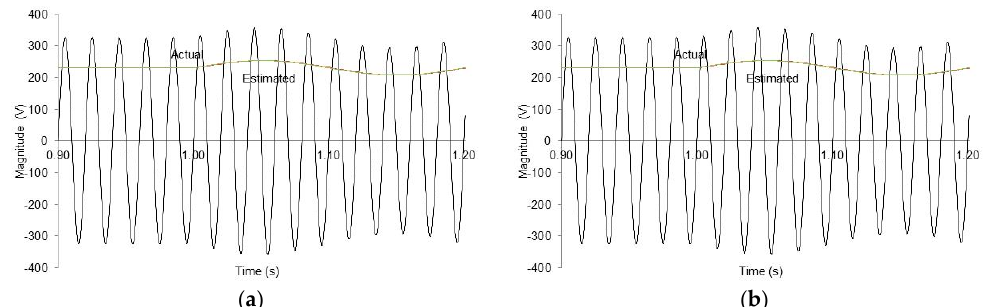
Figure 3. Performance of the method during a 10% magnitude and 0.1 Hz amplitude modulation test: ( a ) magnitude and ( b ) frequency.